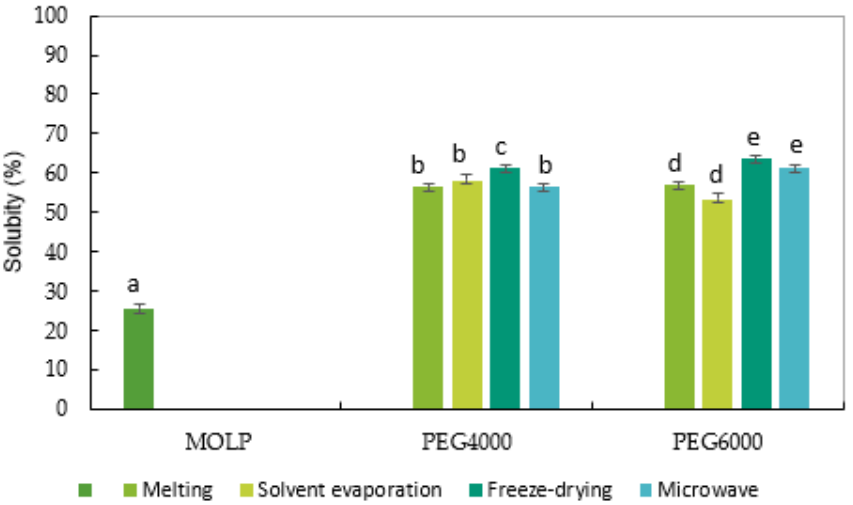
Figure 3. The solubility of the MOLP and solid-dispersed MOLPs prepared through melting, solvent evaporation, freeze-drying, and microwave irradiation using the PEG4000 and PEG6000 carriers. Bars with different superscripts in the same category (PEG) were significantly different ( p < 0.05).